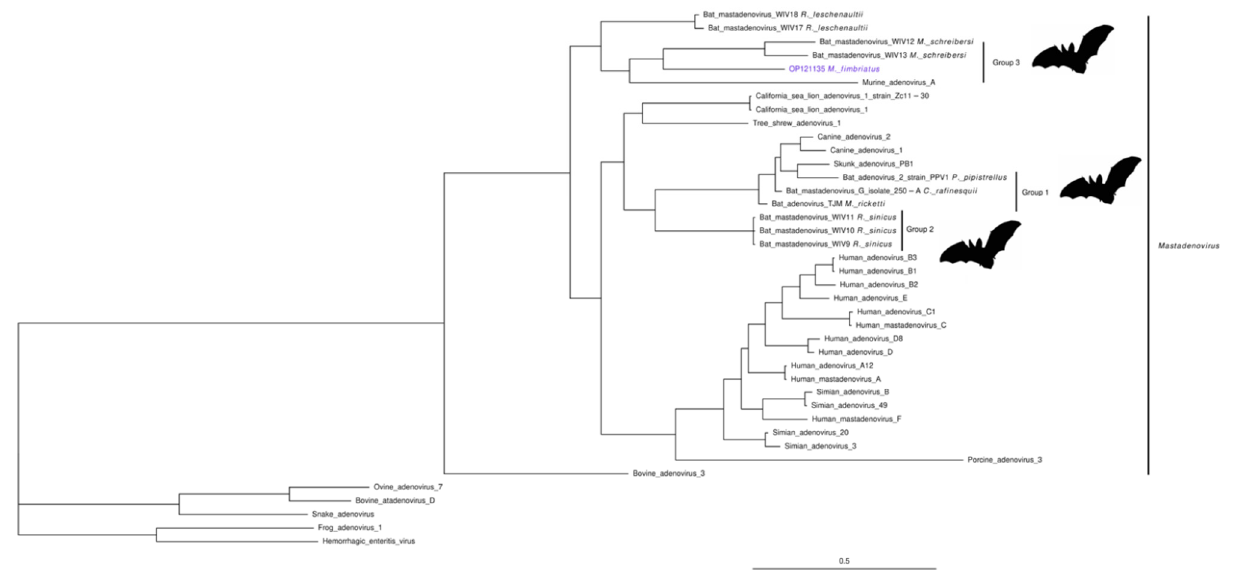
Figure 4. Mastadenovirus. Phylogenetic tree of a 184 a.a region of the pVI protein of representative sequences of the Mastadenovirus genus. Bayesian inference was based on an LG + I + G model. The three groups of bat mamastroviruses are indicated.